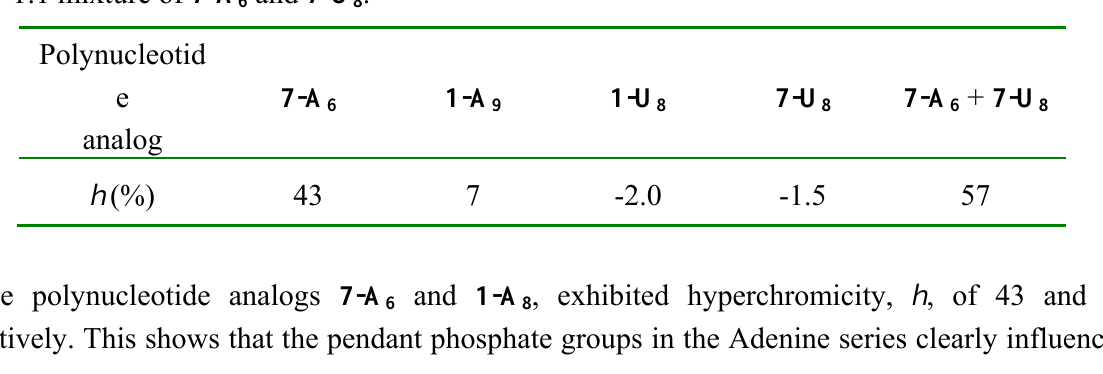
1:1 mixture of 7-A